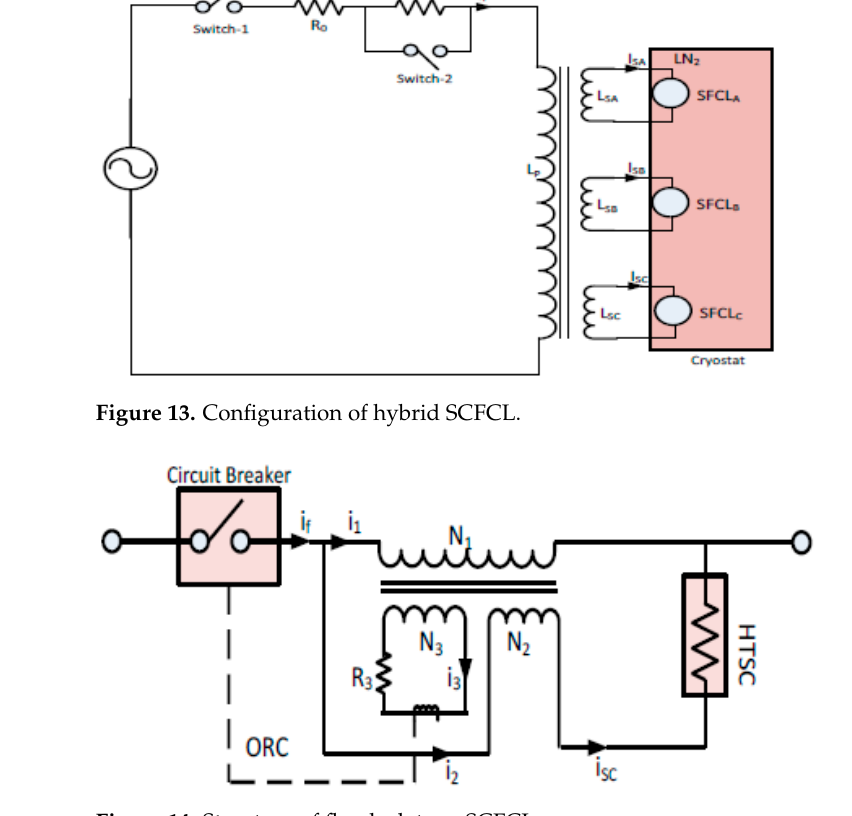
Figure 15. Magnetic Shield SFCL ( a ) Full structural view ( b ) Cross-sectional view.